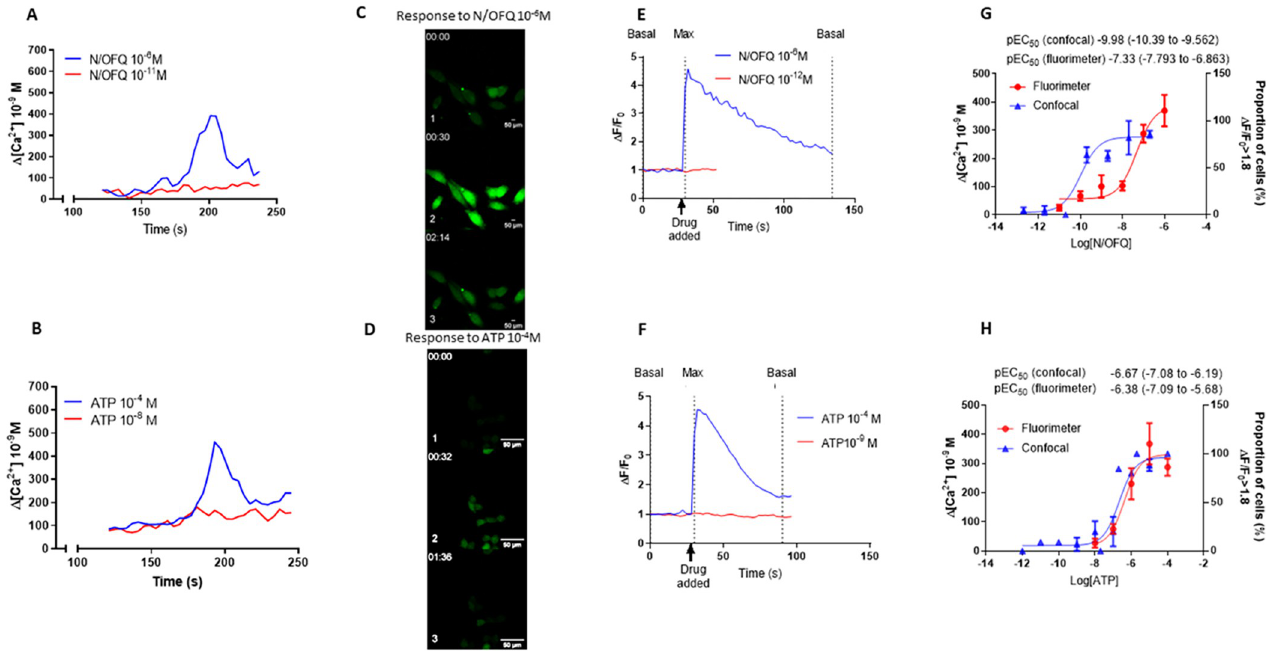
Fig 2. Fluoroscopy and microscopy response to agonists. A. Representative changes in intracellular [Ca 2+ ] in response to exposure to N/OFQ as measured by cuvette based fluorimetry using FURA-2 as an indicator dye. B. Representative changes in intracellular [Ca 2+ ] in response to exposure to ATP as measured by cuvette based fluorimetry using FURA-2 as an indicator dye. C. Representative change in Δ F/F 0 in response to exposure to N/OFQ as measured by confocal microscopy using FLUO-4 as an indicator dye. (1. basal, 2. maximal, 3. decline). D. Representative change in Δ F/F 0 in response to exposure to ATP as measured by confocal microscopy using FLUO-4 as an indicator dye (1. basal, 2. maximal, 3. decline). E. Representative change in Δ F/F 0 in response to exposure to N/OFQ as measured by confocal microscopy using FLUO-4 as an indicator dye. F. Representative change in Δ F/F 0 in response to exposure to ATP as measured by confocal microscopy using FLUO-4 as an indicator dye. G. Concentration-response curves showing maximal changes in intracellular [Ca 2+ ] as measured by fluorimetry (red; n � 3), proportion of cells where maximal Δ F/F 0 � 1.8 (blue; total 1472 cells) as measured by confocal microscopy in response to stimulation by N/OFQ. H. Concentration-response curves showing maximal changes in intracellular [Ca 2+ ] as measured by fluoroscopy (red; n � 3), proportion of cells where maximal Δ F/F 0 � 1.8 (blue; total 51 cells) as measured by confocal microscopy. Error bars show